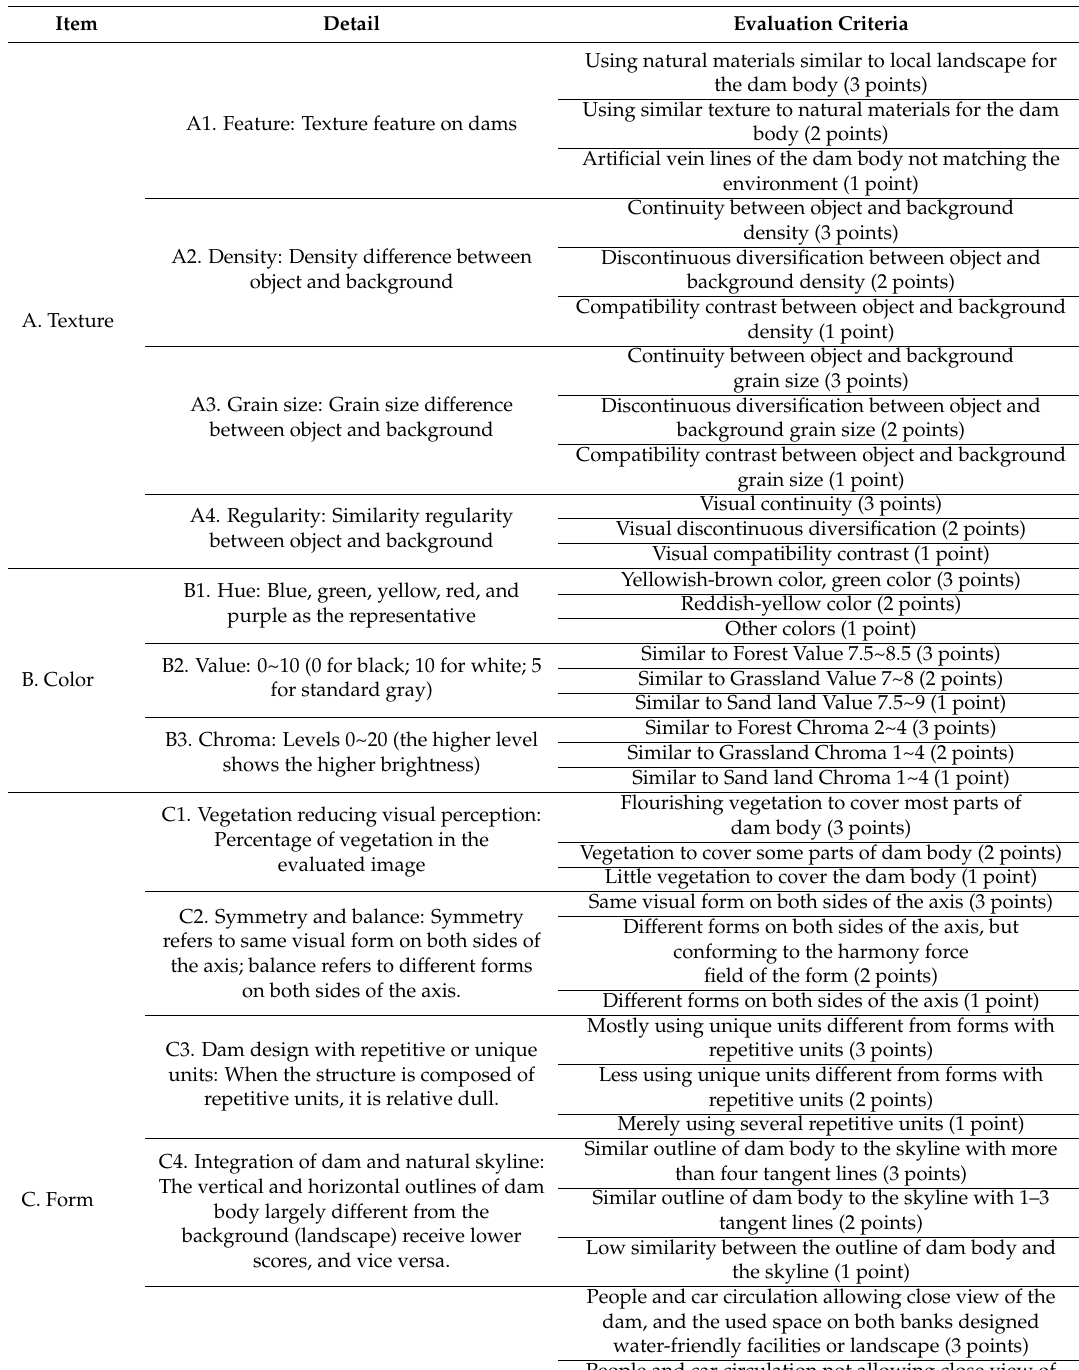
Table 2. Criteria of landscape assessment for check